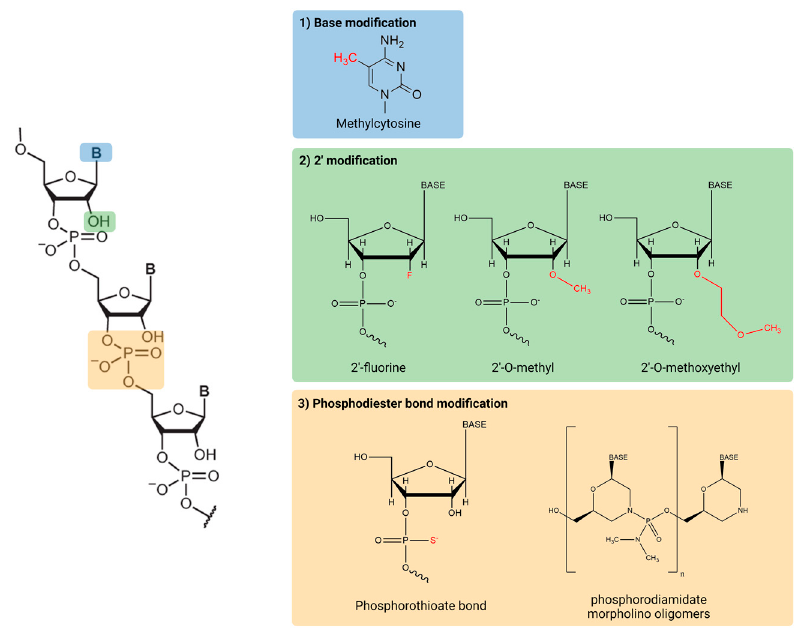
Figure 2. Common chemical structures of RNA therapeutics.